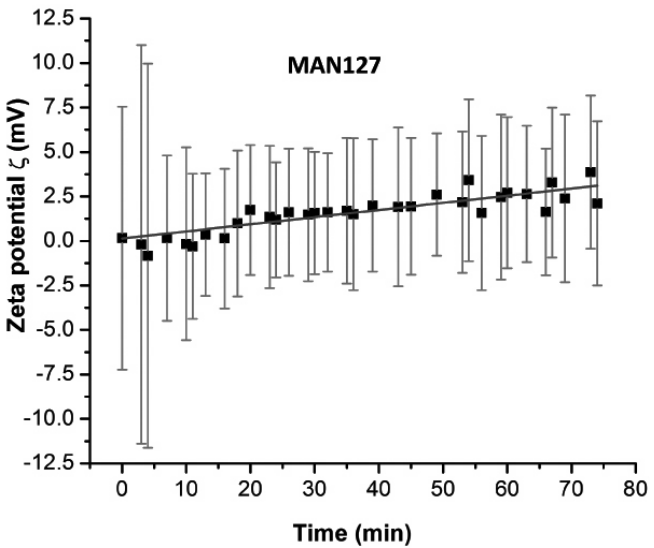
Figure 2. Zeta potential variation over time of MAN127 in presence of DNA.